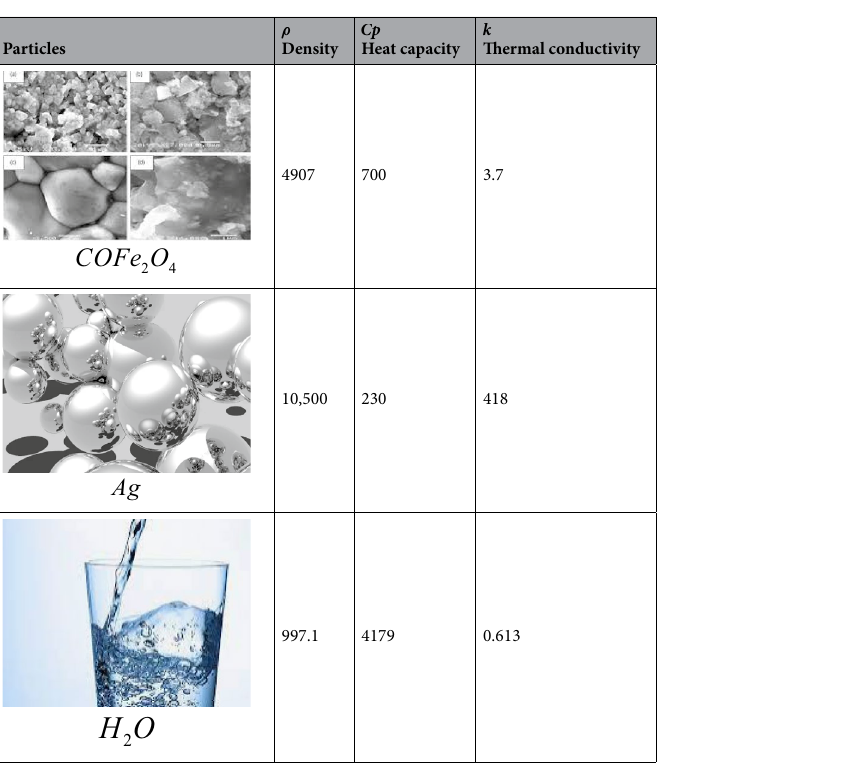
Table 3. Nanoparticle’s thermophysical properties 44,45 .